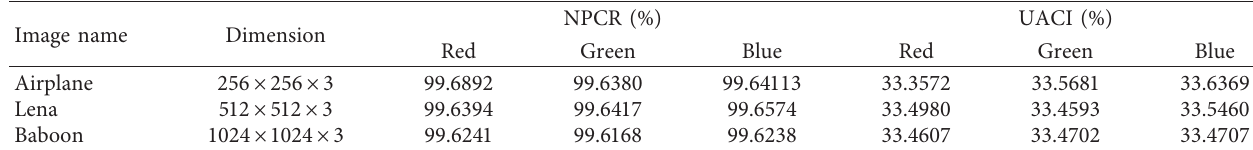
Table 9: NPCR and UACI scores on color images of different